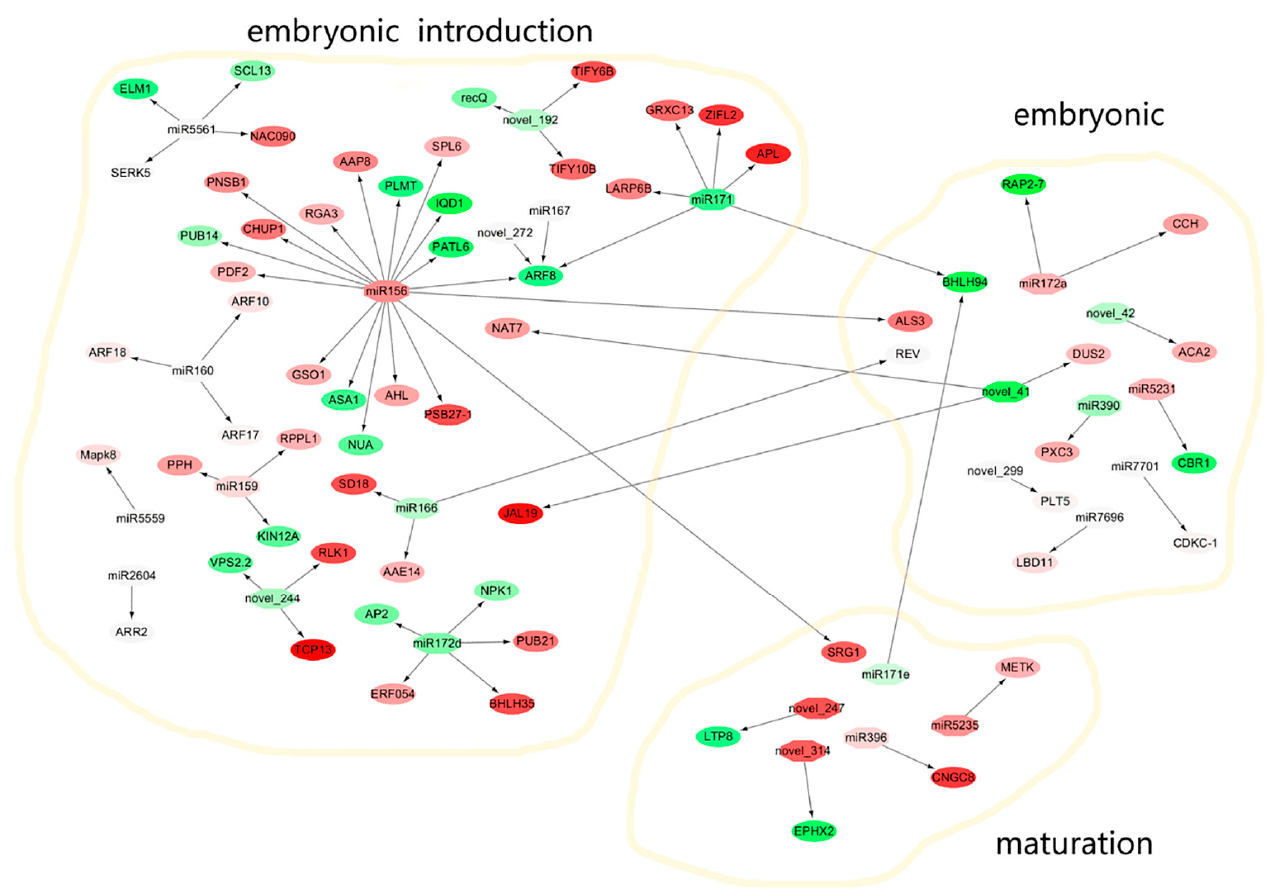
Figure 11. The miRNAs and target genes formed potential miRNA-target gene interaction network during embryonic induction, embyonic and maturation in M.sative SE. Red represents gene upregulation and green represents gene down regulation. The darker the color represent more obvious the difference in expression. Arrows represent the targeting of miRNAs.